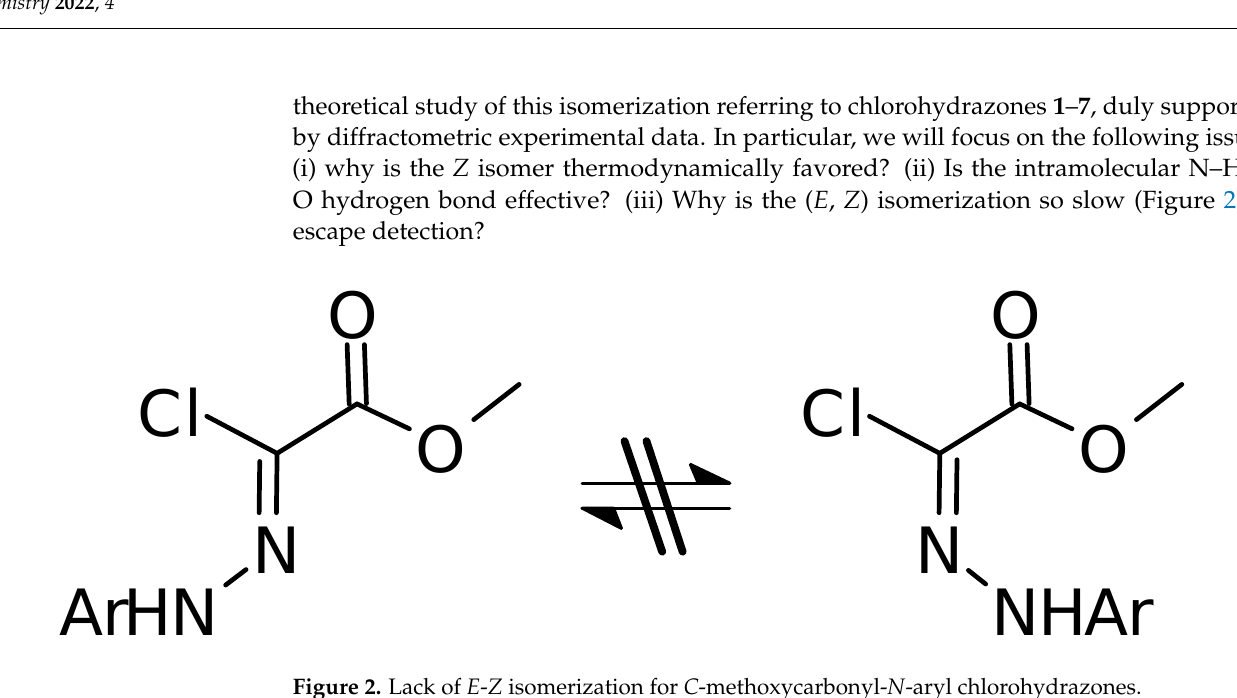
Figure 2. Lack of E - Z isomerization for C -methoxycarbonyl- N -aryl chlorohydrazones.